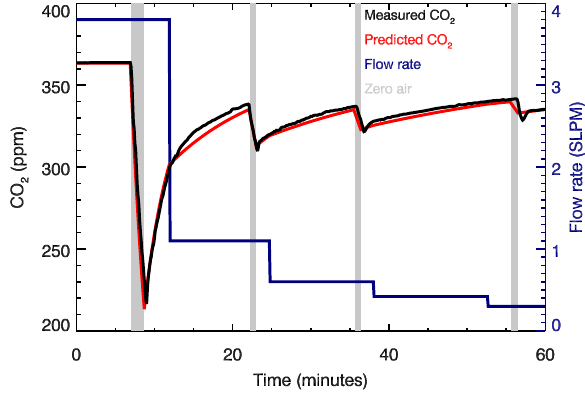
Fig. 4. Test of weighting function. Cylinder air at room pressure was flowed through the integrating system at the indicated flow rates (blue). Note that the flow rates in this experiment were slightly dif- ferent than our standard protocol used in Fig. 3. Natural 363.5ppm CO 2 air was flowed through the system for 20min prior to the start of the experiment and during the experiment, except during the pe- riods shaded in grey, when incoming air was switched to zero air. The measured CO 2 mole fraction exiting the system is indicated in black, and was 335.3ppm at the end of the integrating time (60min). Predicted values at each time step are shown in red, and the final predicted value was